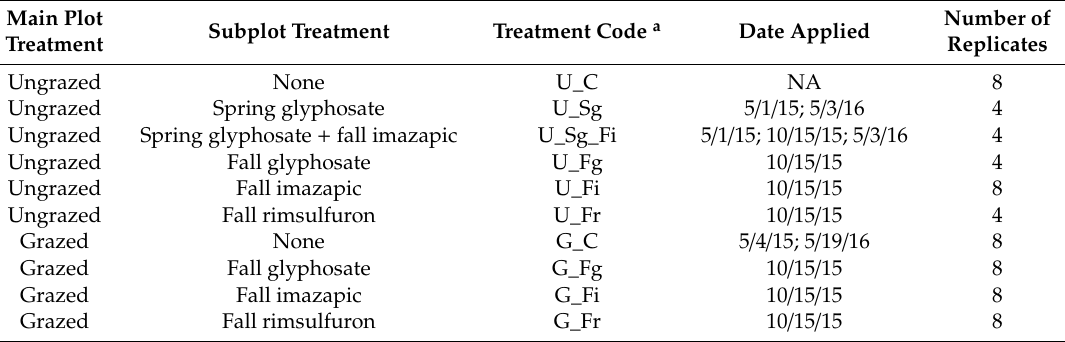
Table 1. List of treatments applied to manage cheatgrass at Red Blu ff ,